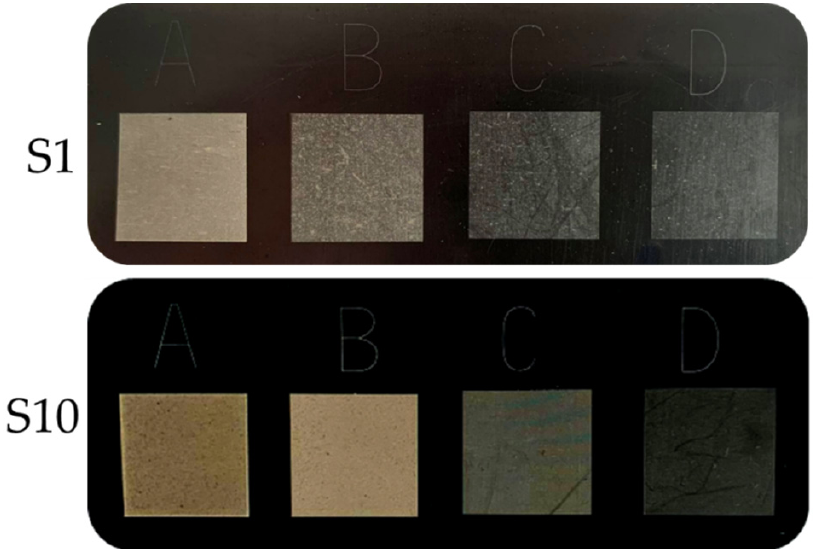
Figure 11. Graphic signs applied with different laser operating parameters: ( A ) 450 mm/s, 0.03 mm; ( B ) 750 mm/s, 0.05 mm; ( C ) 1050 mm/s, 0.07 mm; ( D ) 1350 mm/s, 0.09 for samples S1 and S10.